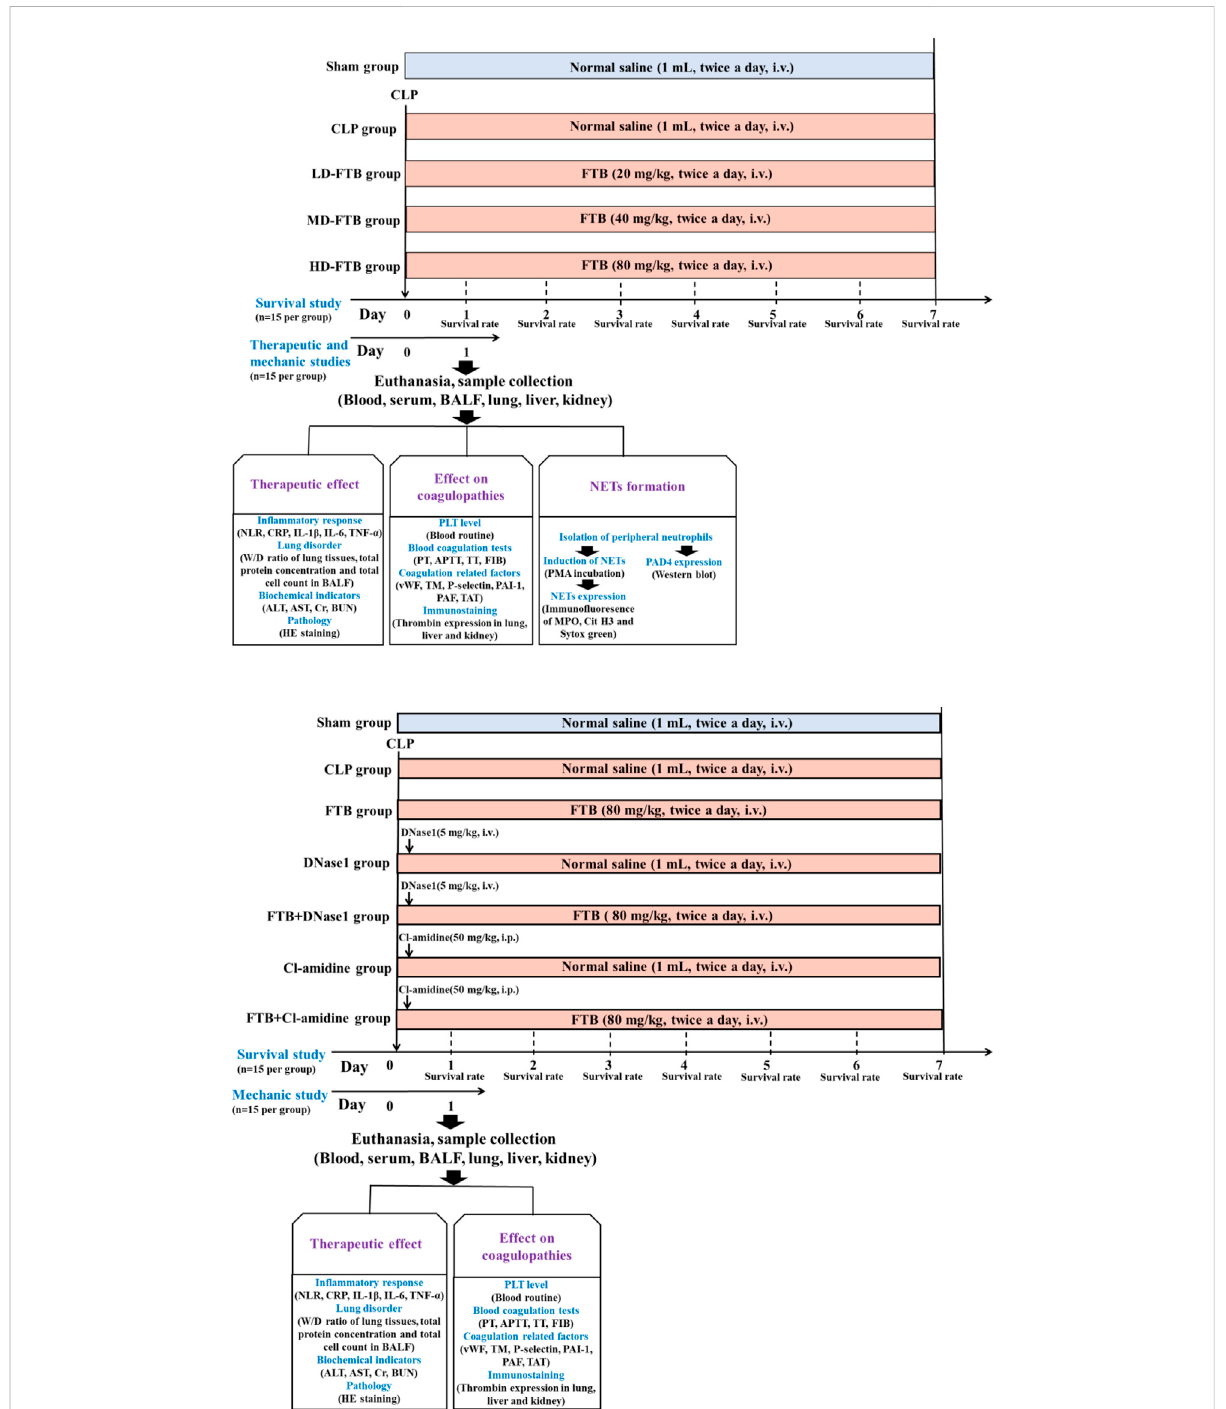
FIGURE 1 Overview of the experimental design of the study assessing the therapeutic effects of forsythiaside B (FTB) on sepsis (A) and of the study assessing the involvement of neutrophil extracellular traps (NETs) and peptidylarginine deiminase 4 (PAD4) in the effect of FTB using corresponding inhibitors (B) . (A) Rats were subjected to cecal ligation and puncture (CLP) to induce sepsis and were treated with different dosages of FTB; the survival rate was calculated for 7 days after CLP (n = 15 per group). The effects of FTB on the markers of the disease and NETs formation